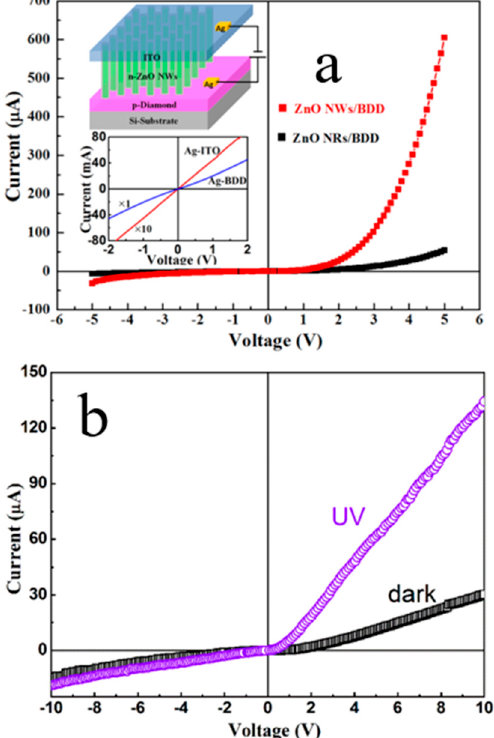
Figure 14. ( a ) I-V characteristics of the n-ZnO NWs/p-BDD and n-ZnO NRs/p-BDD heterojunctions, respectively. The top inset shows the schematic diagram of n-ZnO NWs/p-BDD heterojunction; the bottom inset shows ohmic contacts measurements for Ag/ZnO and Ag/BDD [30]. ( b ) I-V characteristics of n-ZnO NRs/p-BDD heterojunction with UV illumination and dark, respectively [22].